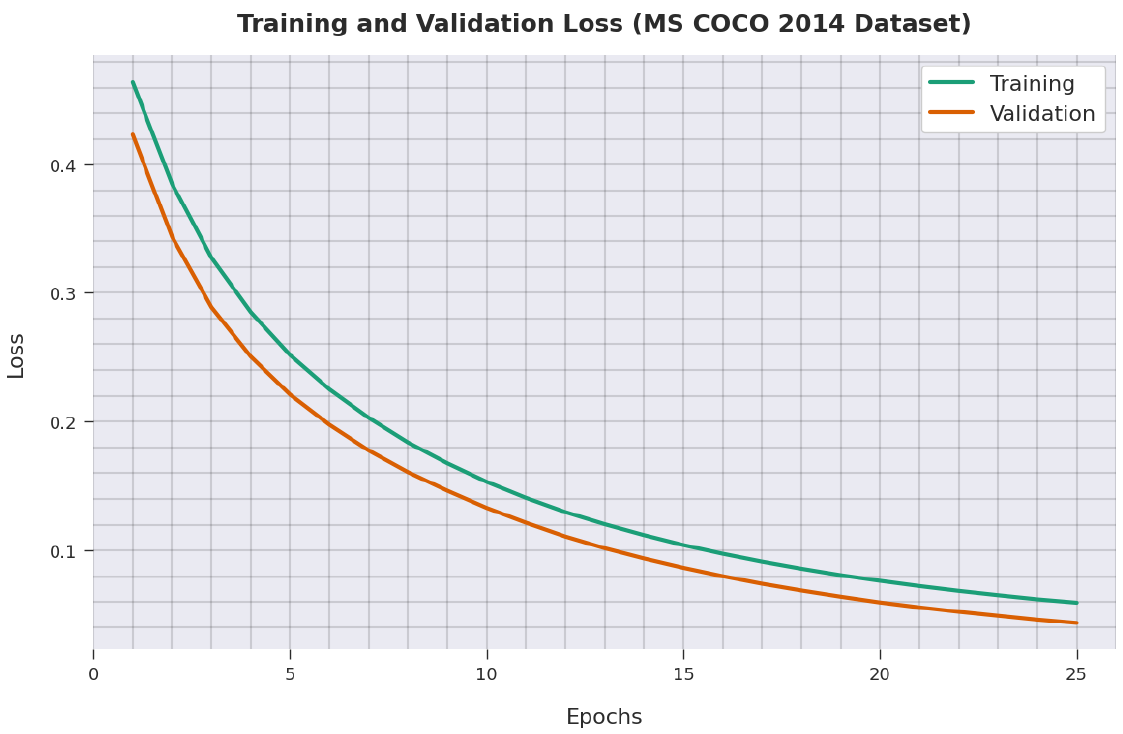
Figure 12. TL and VL analysis of the MODLE-AICT technique on MS-COCO 2014